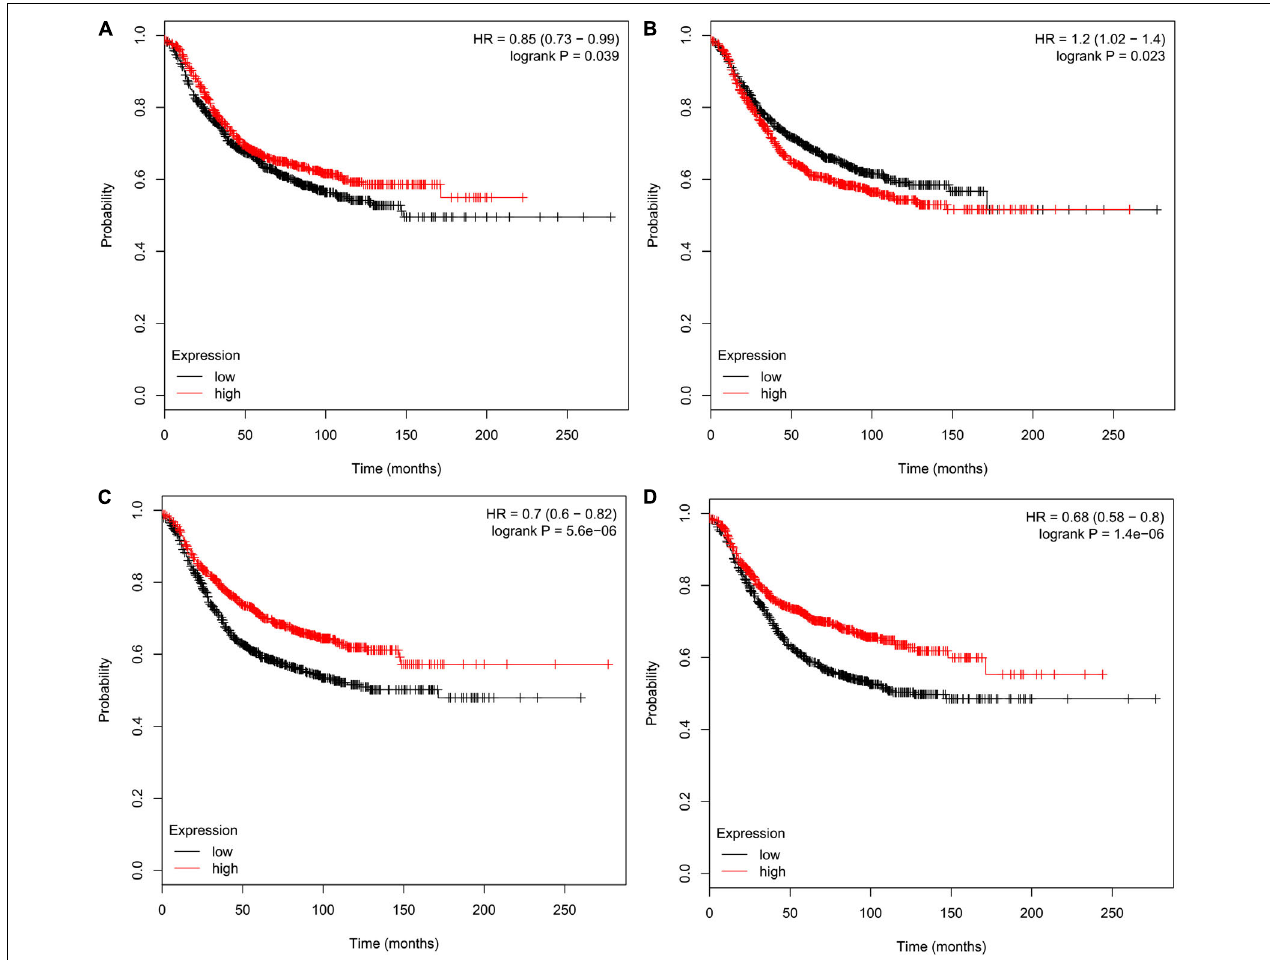
FIGURE 4 | Relapse-free survival analysis of CMTM family members in breast cancer using the Kaplan–Meier plotter. (A) CMTM3 , (B) CMTM4 , (C) CMTM5 , and (D) CMTM7.